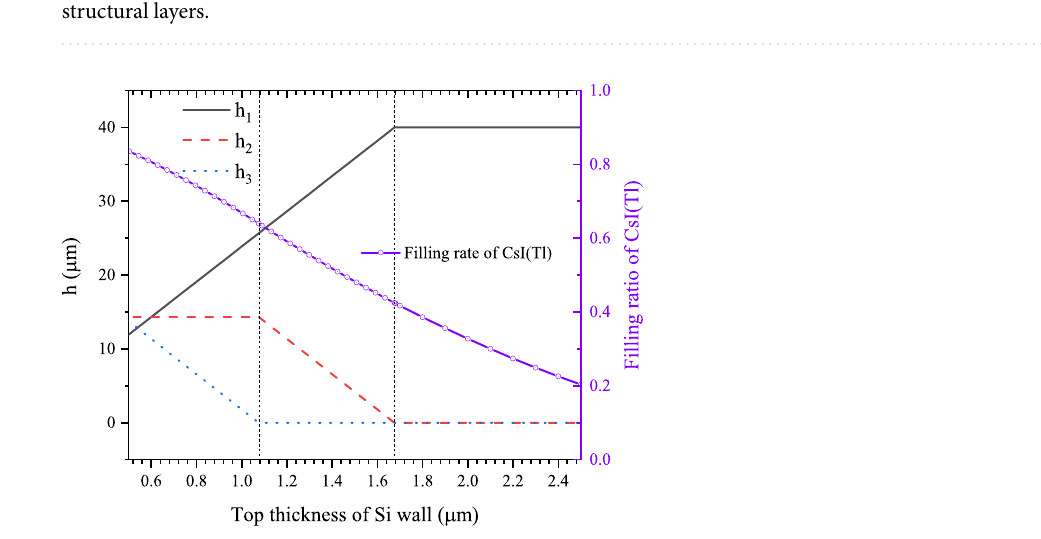
Figure 1. Side view of the CsI(Tl) micro-square-frustums structured scintillation screen with different t Si . As t